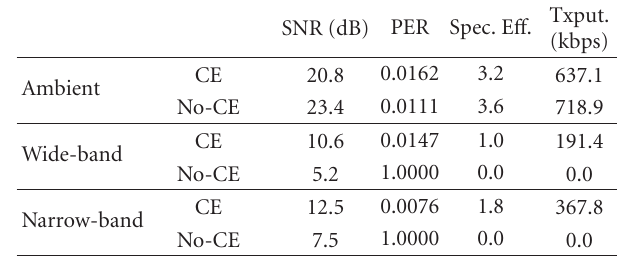
Table 7: Mean values of the